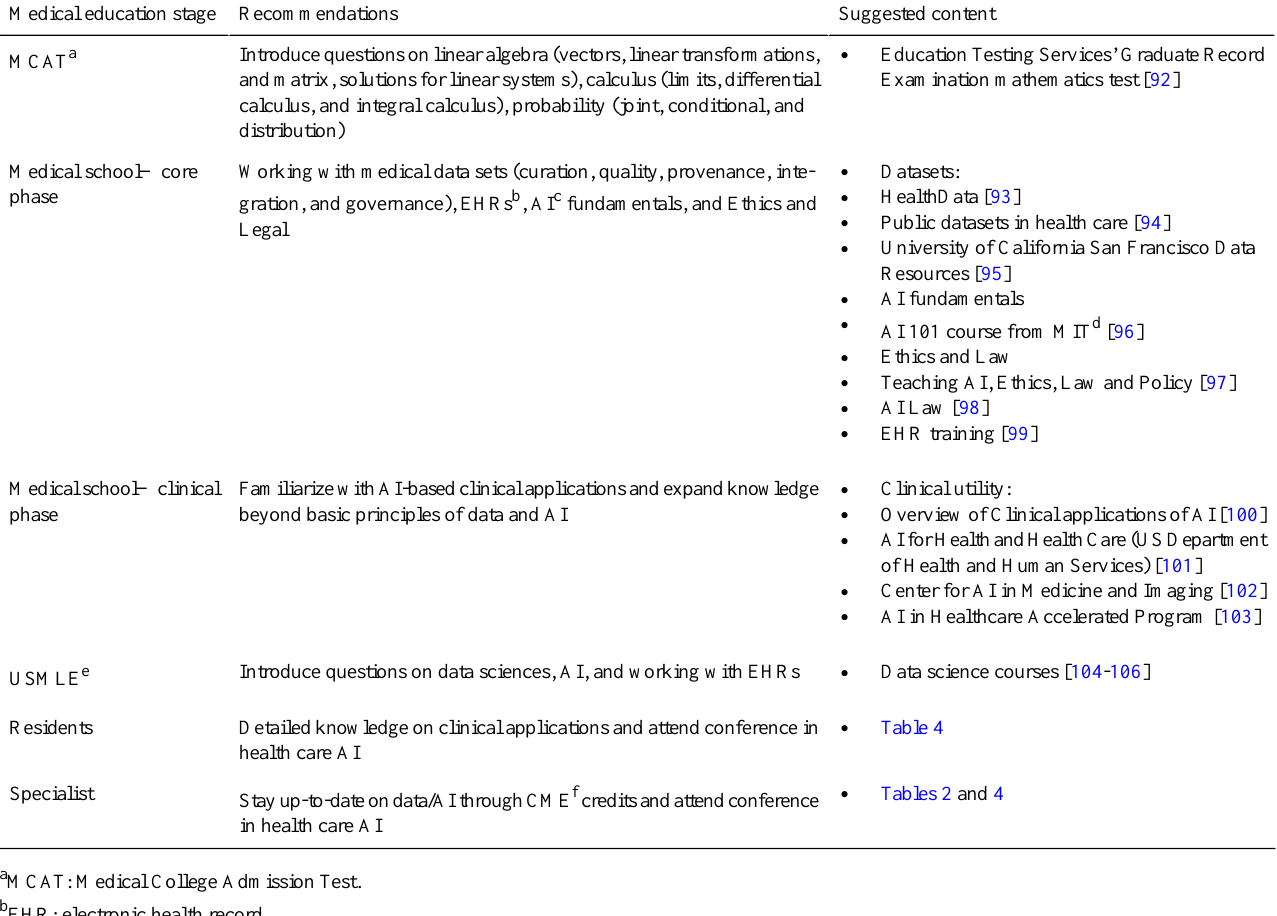
Table 3. Recommendations per stage of medical education.